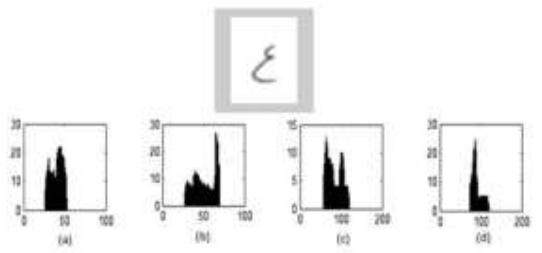
Figure 4. Projection Profile in 4 dimensions. a)Vertical